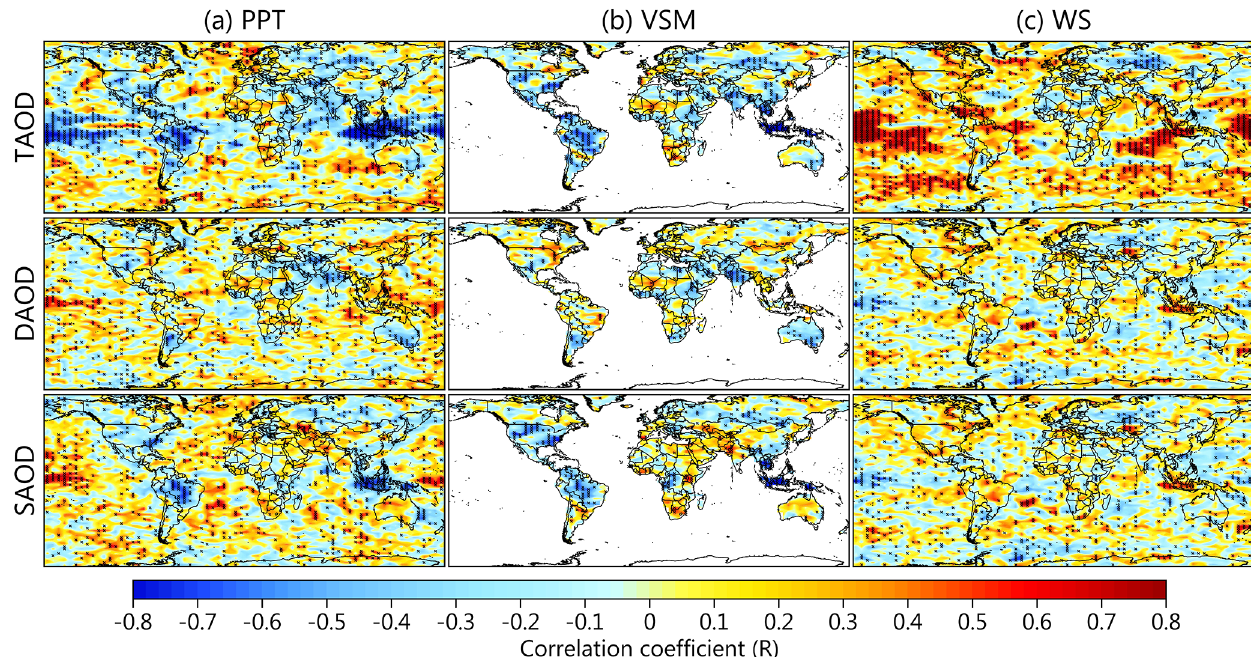
Figure 17. Spatial distributions of the correlation coefficients ( R ) for TAOD, DAOD, and SAOD versus (a) precipitation (PPT), (b) volumetric soil moisture (VSM), and (c) wind speed at 10m (WS) for 2007–2019. The grid points with R values that are statistically significant at the 90% confidence level are marked with black ×